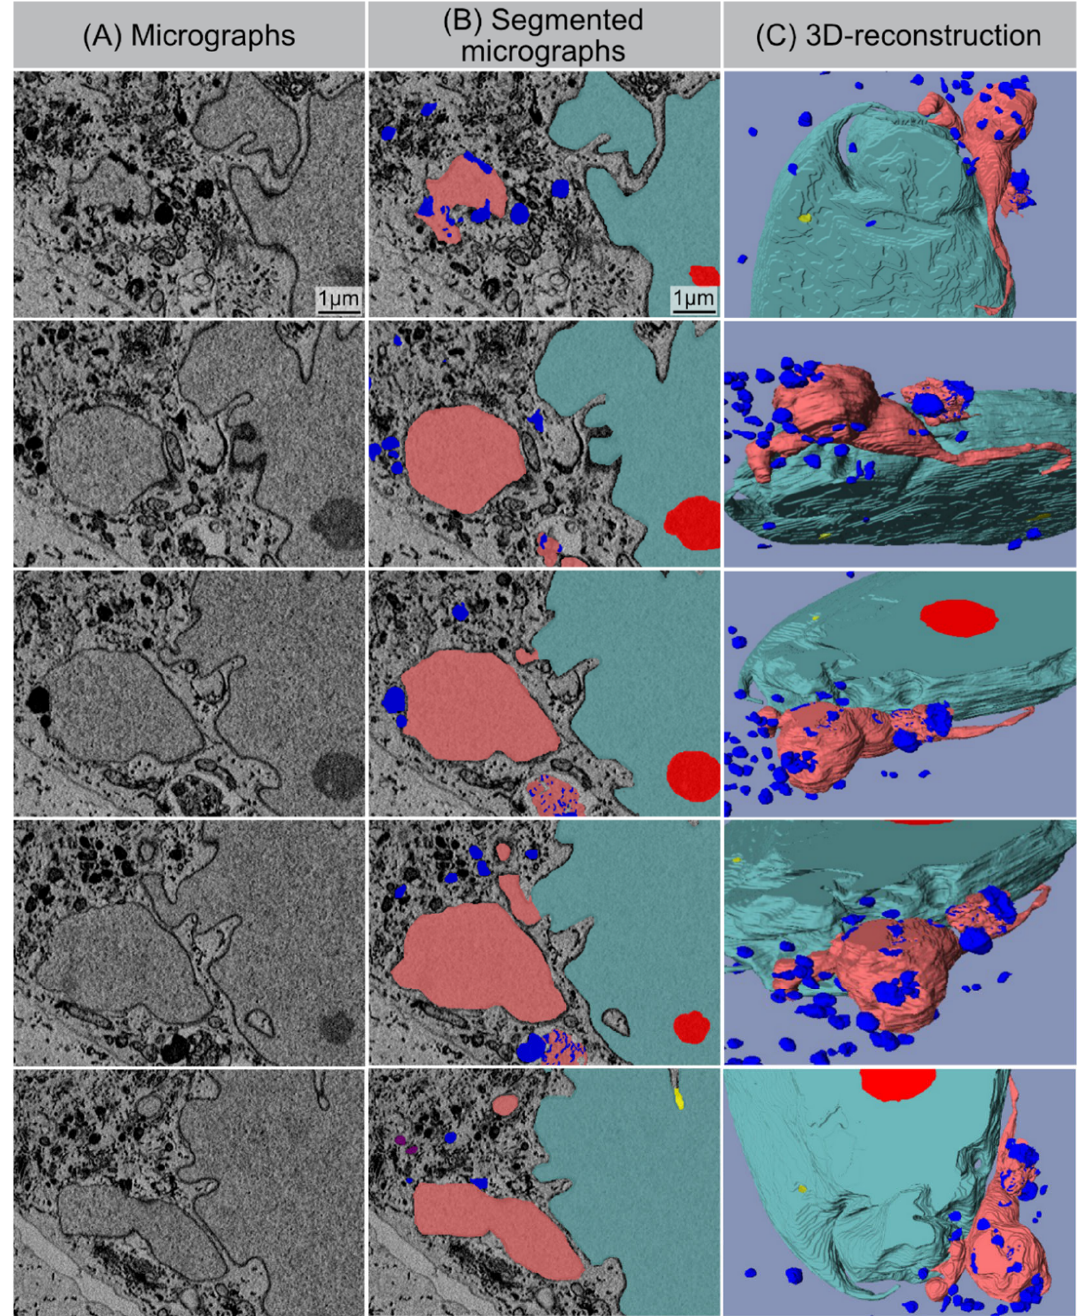
Figure 5 . SBF ‐ SEM: Separation process of CCF. ( A ) Original micrographs presenting detaching CCF. ( B ) Segmented micrographs of the same regions. ( C ) 3D reconstruction of detaching CCF: nucleus (light ‐ blue), nucleoli (red), lysosomes (blue), and CCF (light ‐ red), nanotubes (yellow).